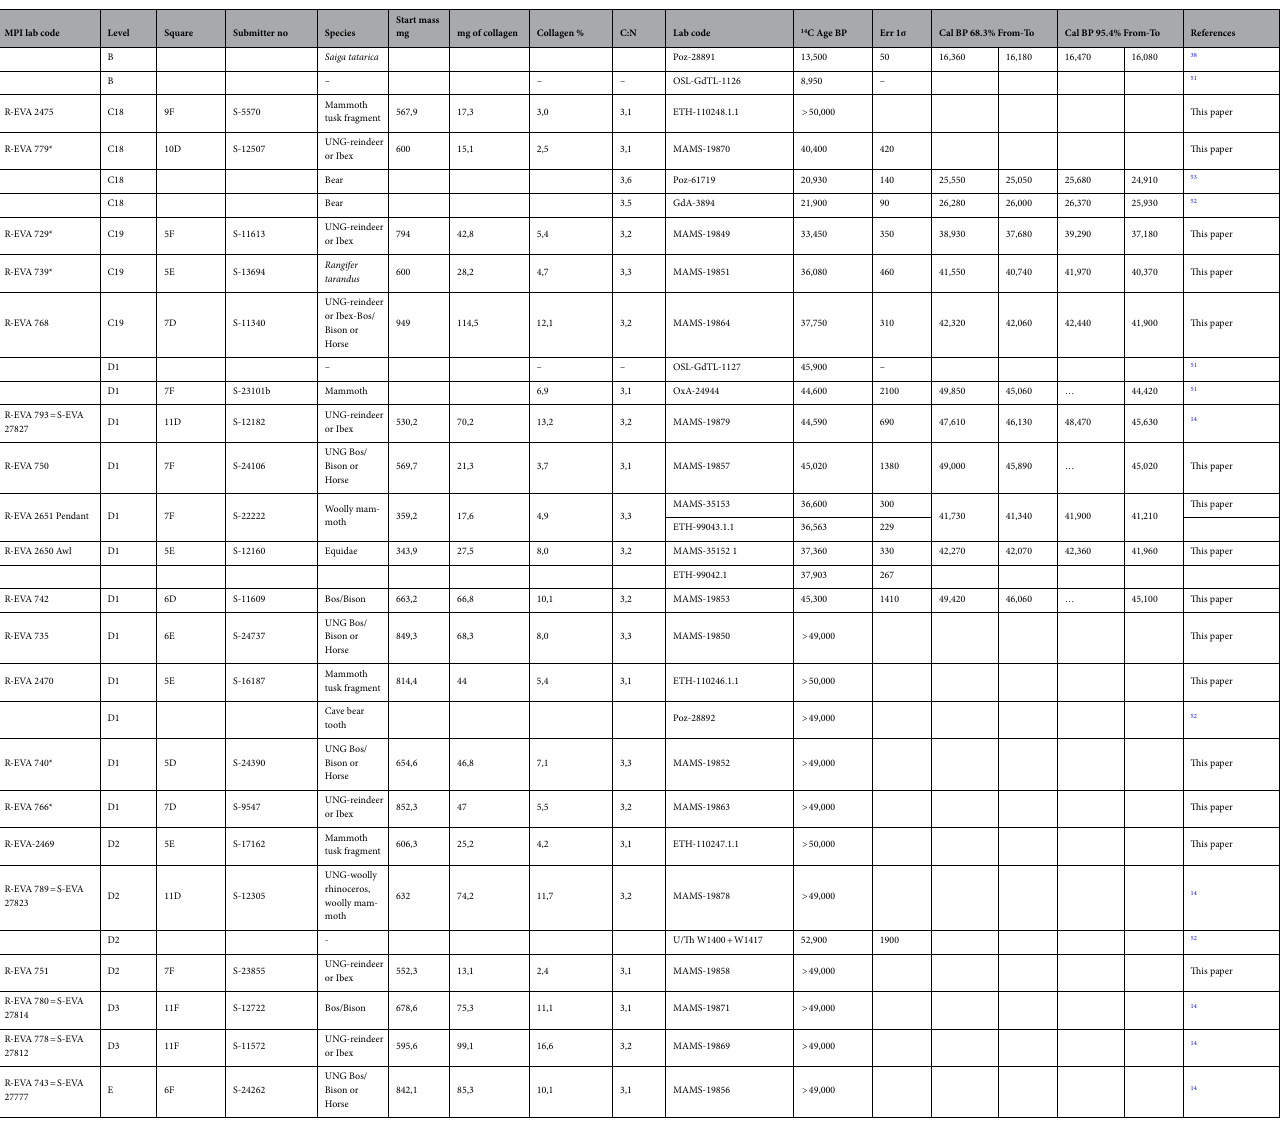
Table 1. The results of AMS radiocarbon dating and OSL from Stajnia. For 20 samples, stable isotopic analysis was evaluated at MPI-EVA, Leipzig (Lab Code S-EVA), using a ThermoFinnigan Flash EA coupled to a Delta V isotope ratio mass spectrometer. The bones with human modifications are indicated by an asterisk in the MPI Lab Code. Results are rounded to the nearest 10